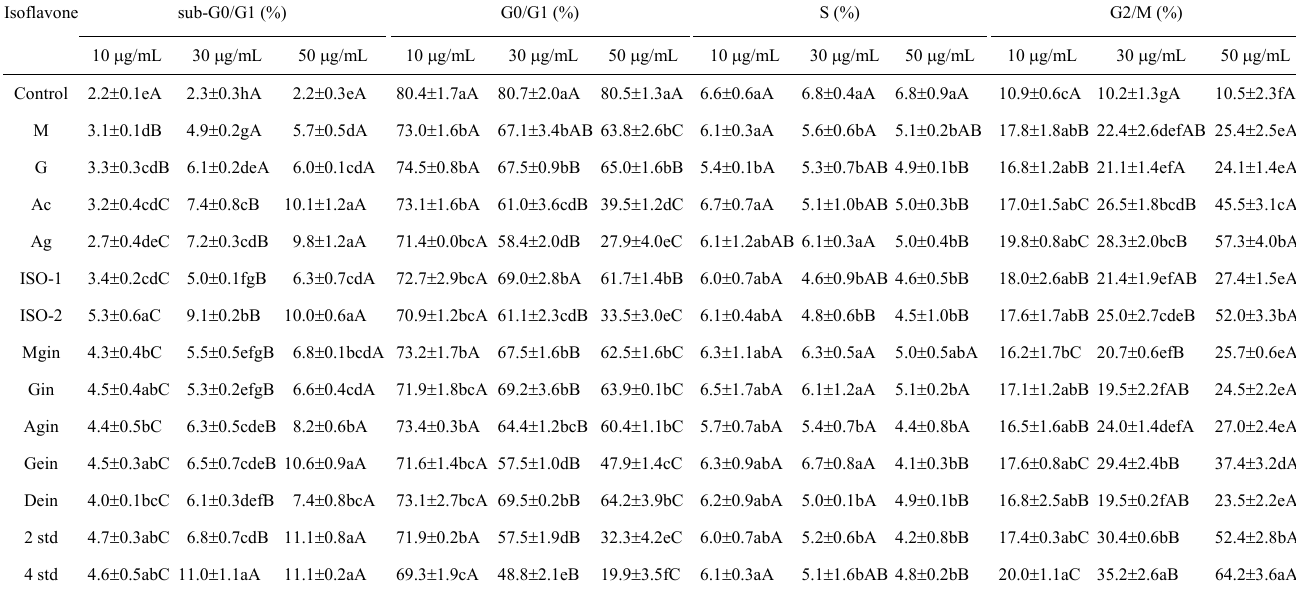
Table 3. Effect of isoflavone fractions and extracts as well as standards on cell cycle distribution of Hep G2 cells A